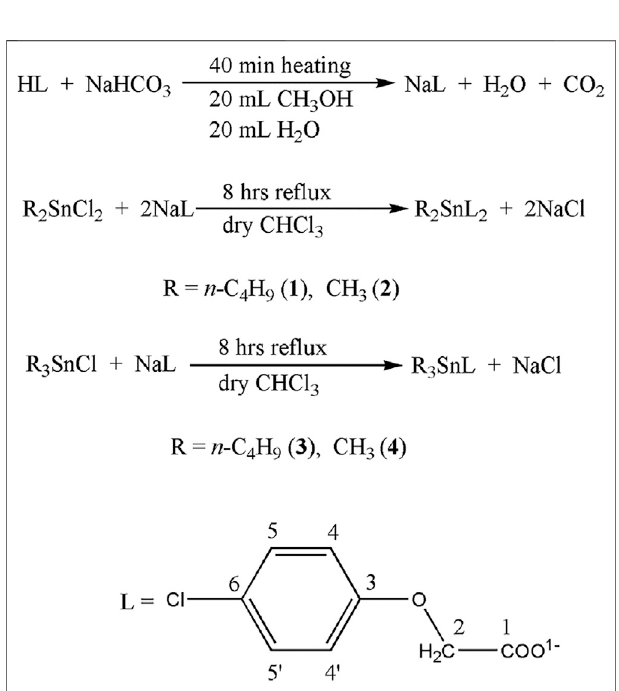
SCHEME 1 | Synthetic procedure for NaL and complexes 1 – 4